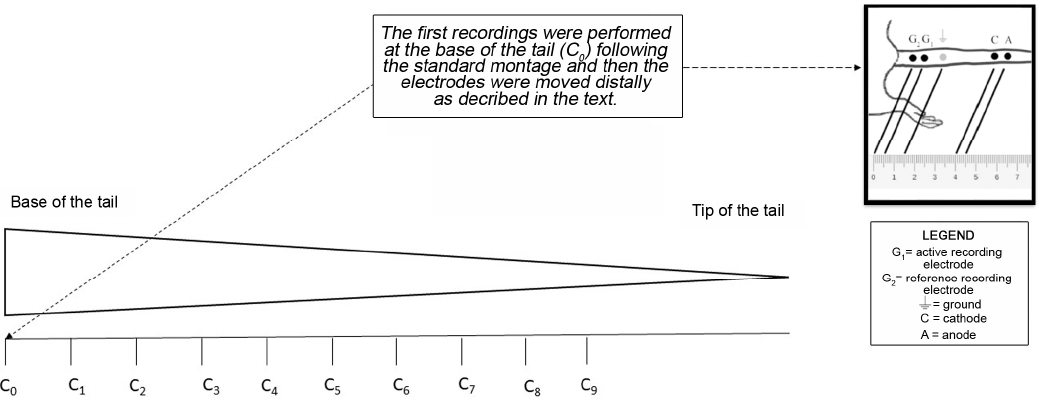
Figure 7. Neurophysiological recordings montage of the caudal nerve for its whole length. The image represents the whole tail of the rat. The C 0 site (i.e., base of the tails) was the starting point of recordings. In the upper right part of the image the reciprocal position of anode, cathode, active and recording electrodes, and ground electrodes is shown. The measurements were repeated moving the electrodes distally, keeping the interelectrode distances constant.